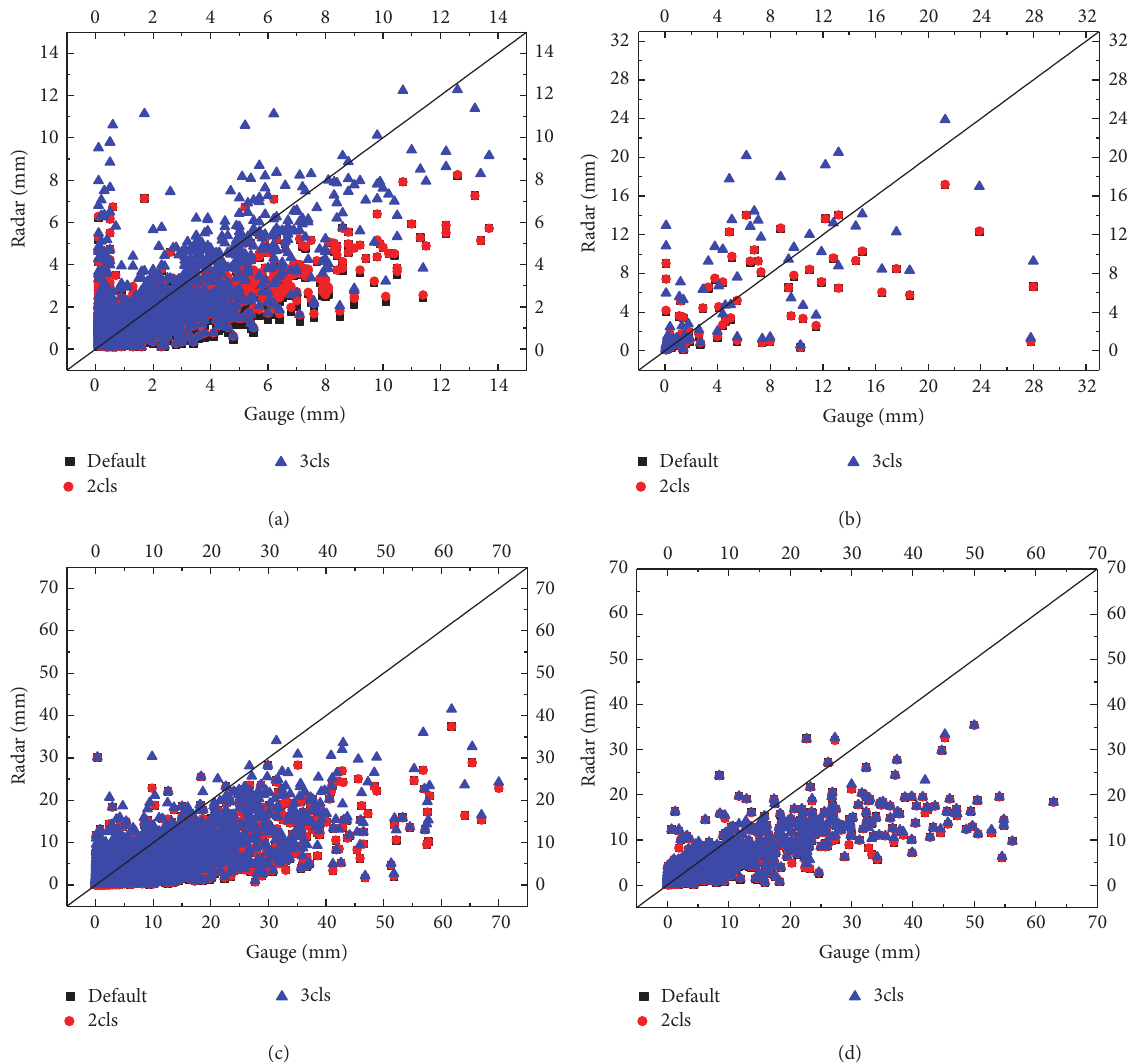
Figure 6: Scatter plot of gauge versus radar-derived 6-h accumulated precipitation estimates (case 3 uses 4-h accumulated precipitation values). (a) Case 1. (b) Case 3. (c) Case 6. (d) Case 7. (The diagonal line represents the ideal line, corresponding to an equality between the radar and gauge